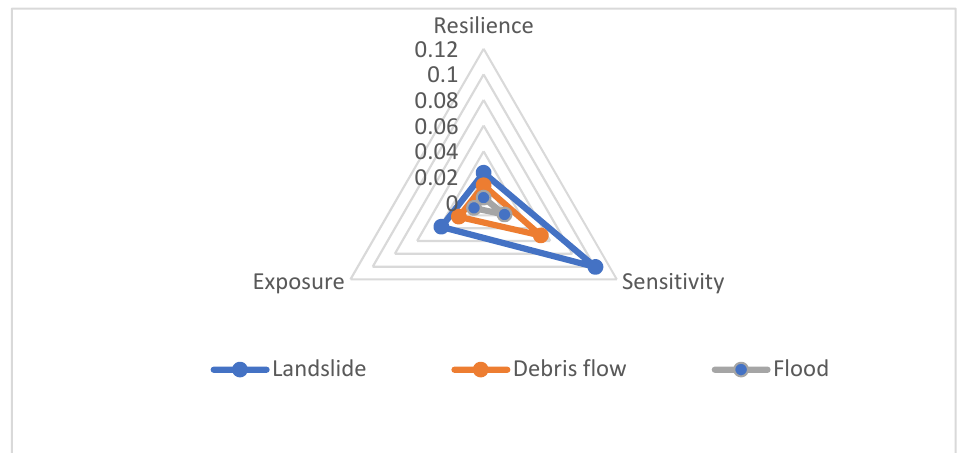
Figure 2. Tringle diagram of vulnerability of different types of disasters based on IPCC-LVI scores.